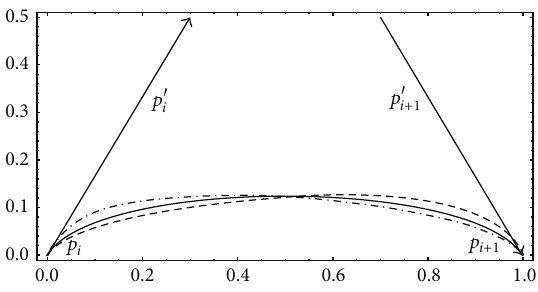
Figure 2: The Ferguson curve with different